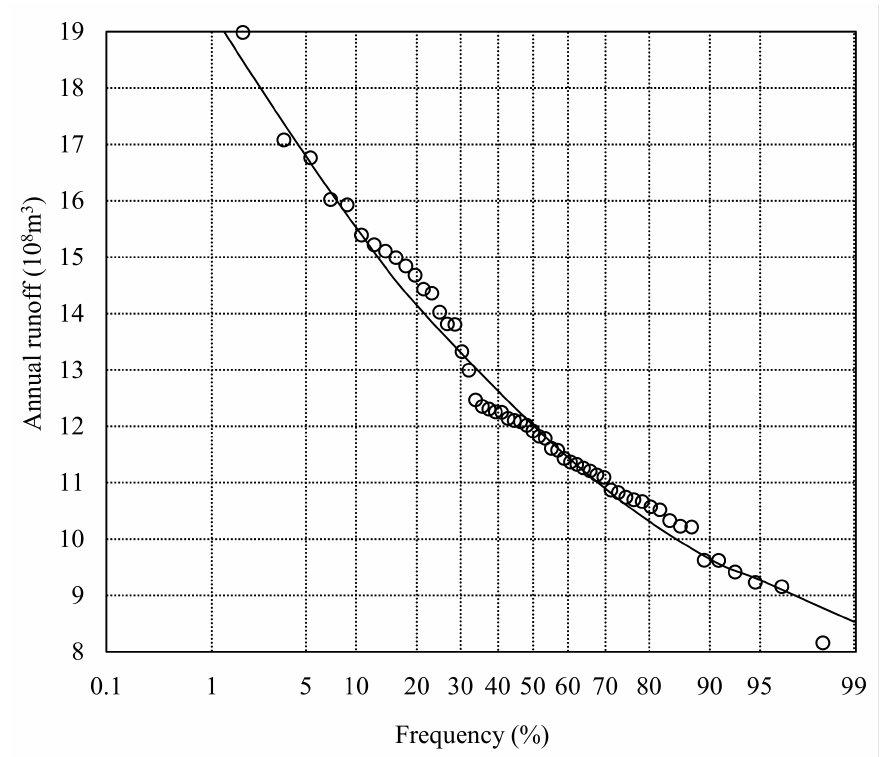
Figure 3. The P-III hydrographic